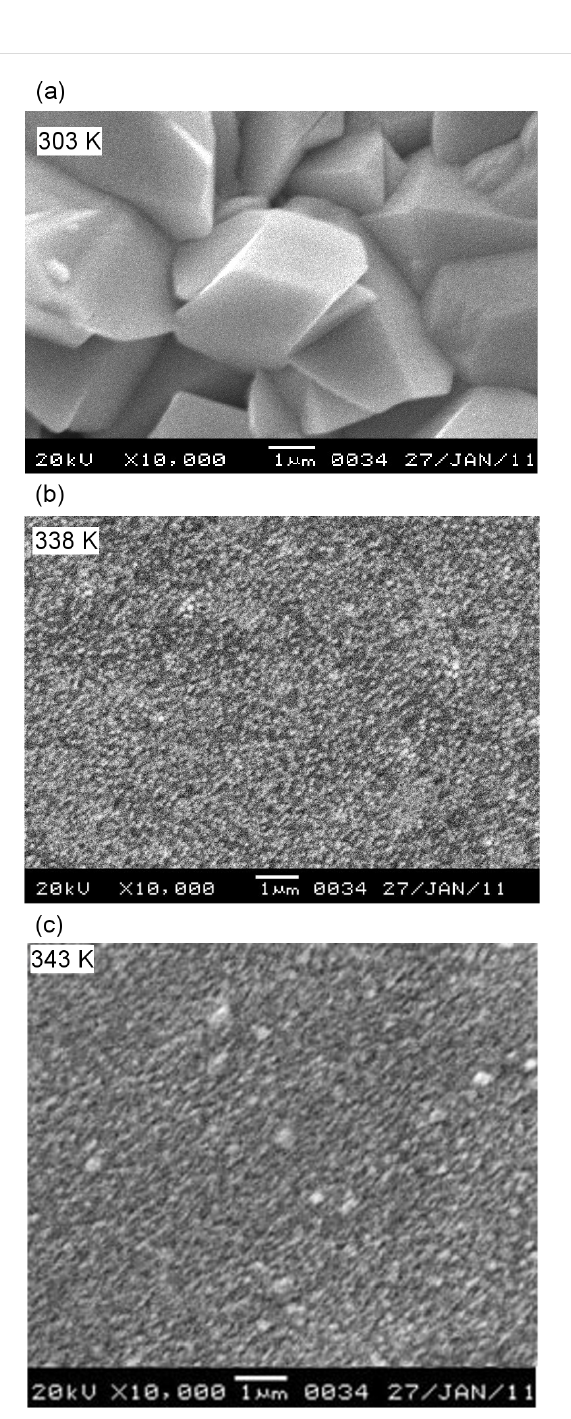
Figure 5: SEM micrograph of PbSe prepared at (a) 303 K (b) 338 K and (c) 343 K.